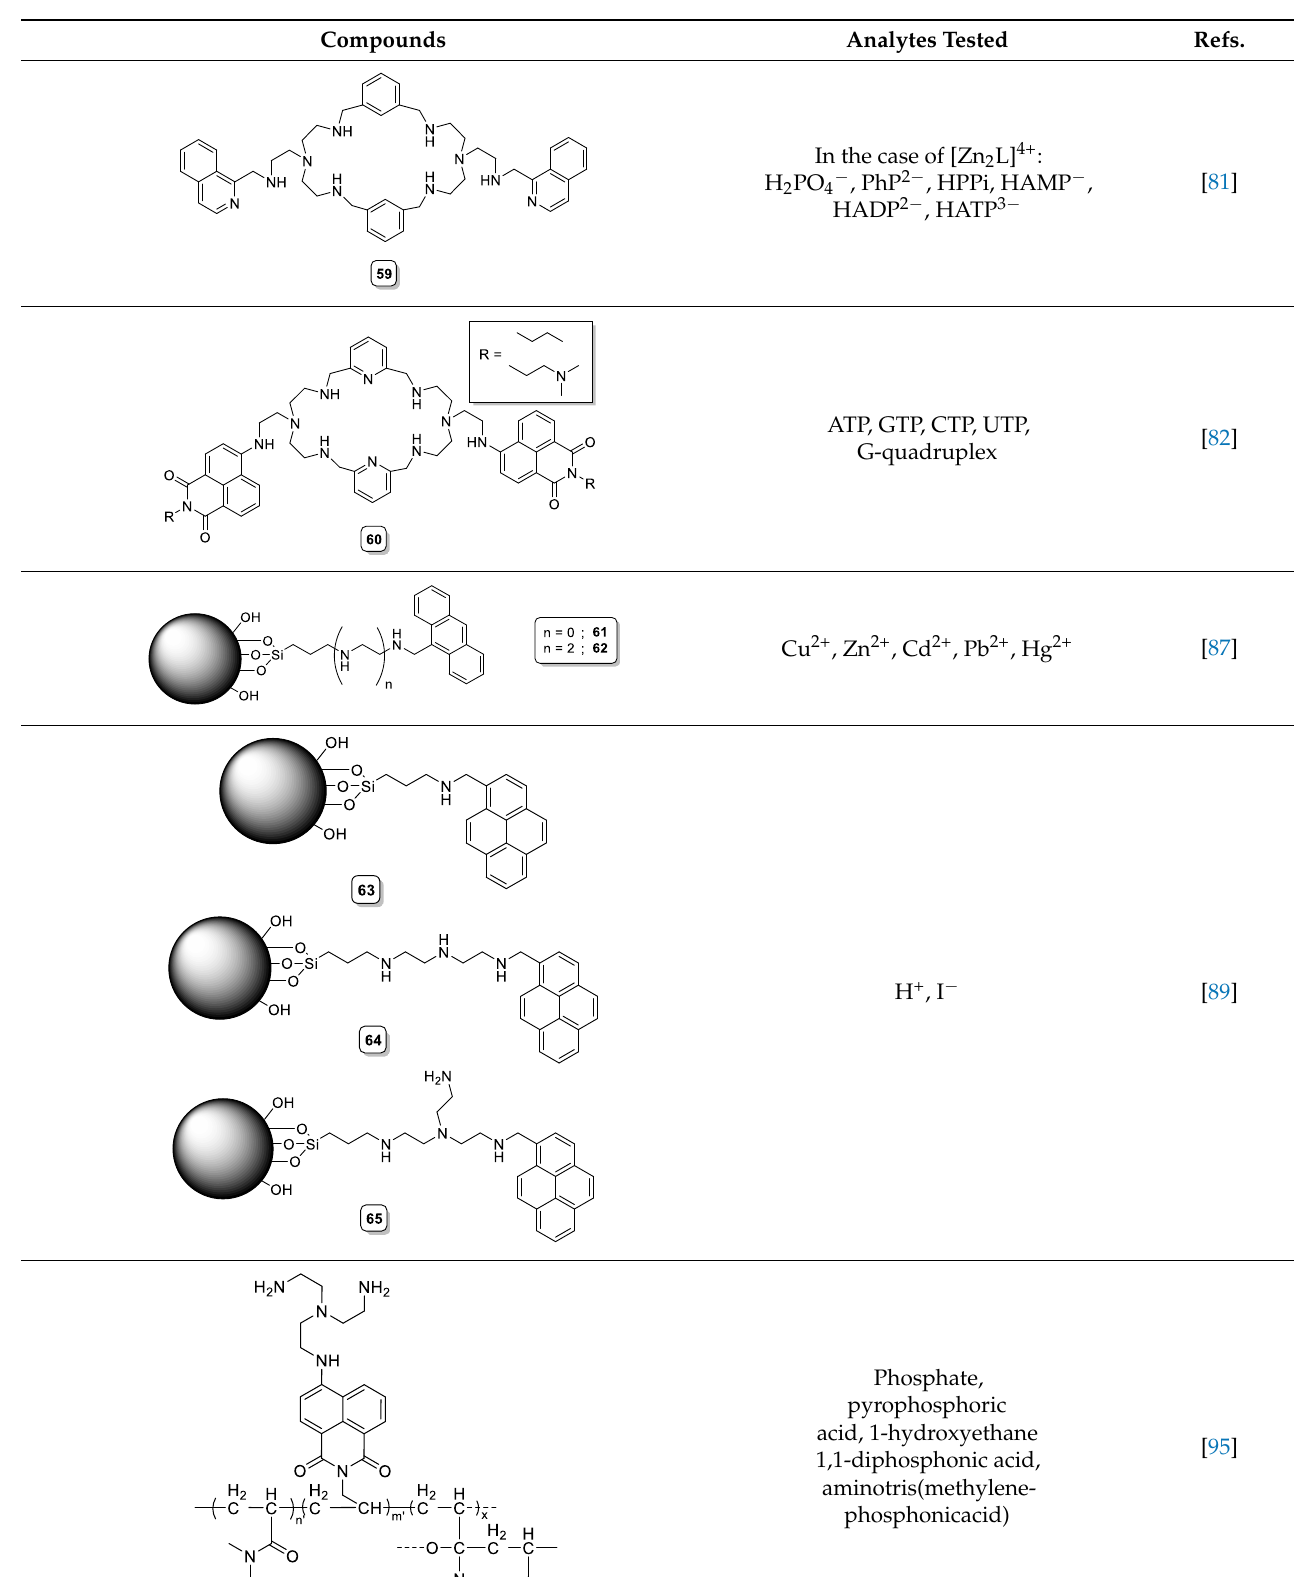
Table A1. Cont. Compounds Analytes Tested Refs.